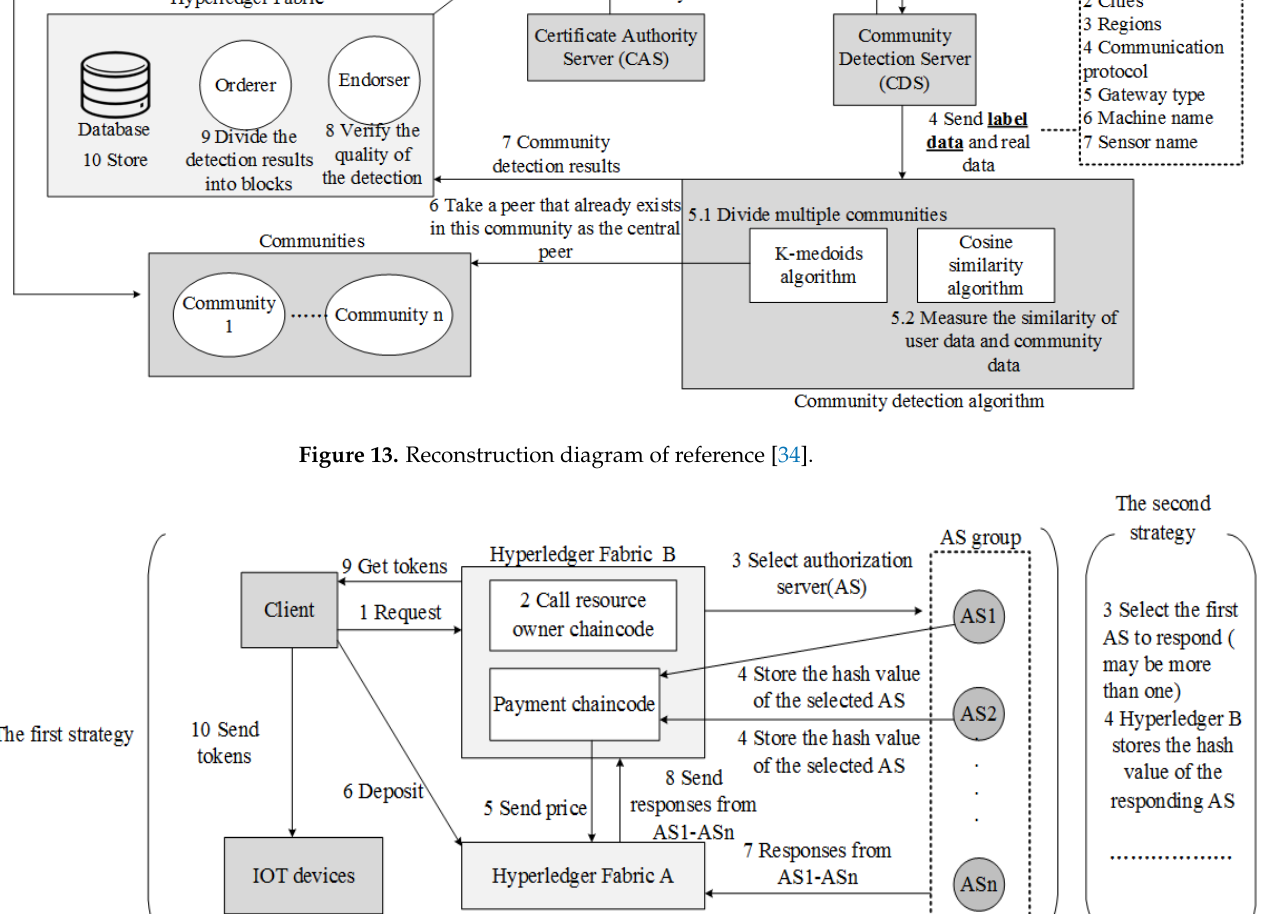
Figure 13. Reconstruction diagram of reference [34].